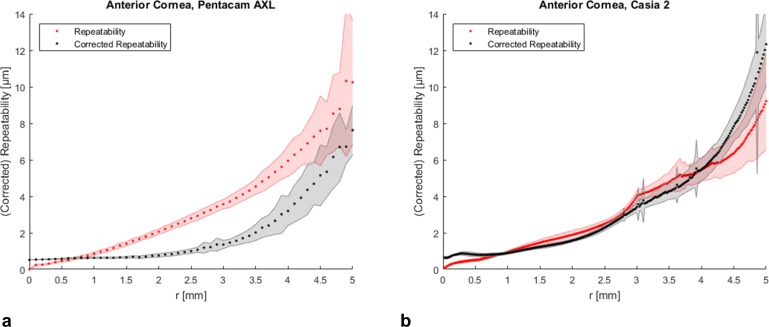
Repeatability and corrected repeatability of anterior corneal elevation.(a) Repeatability (red) and corrected repeatability (black) of anterior corneal elevation data maps obtained with Pentacam AXL and (b) CASIA 2 averaged along concentric rings ± standard deviation (shaded area) as a function of the radial distance r from the corneal apex.